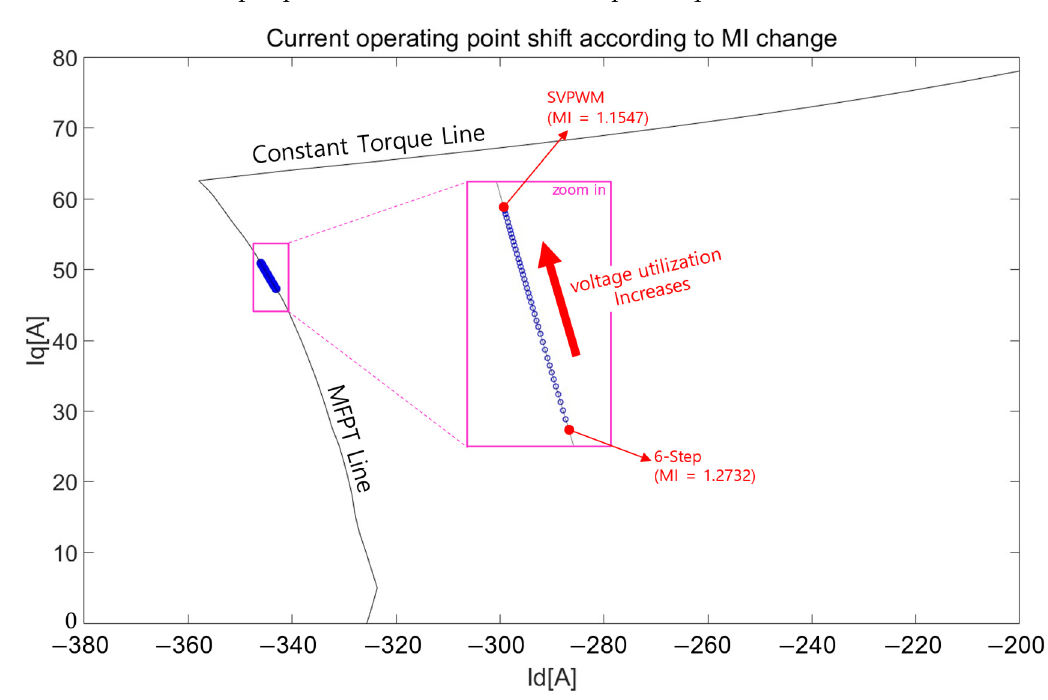
Figure 11. Test point for observing the efficiency change on an MFPT curve.